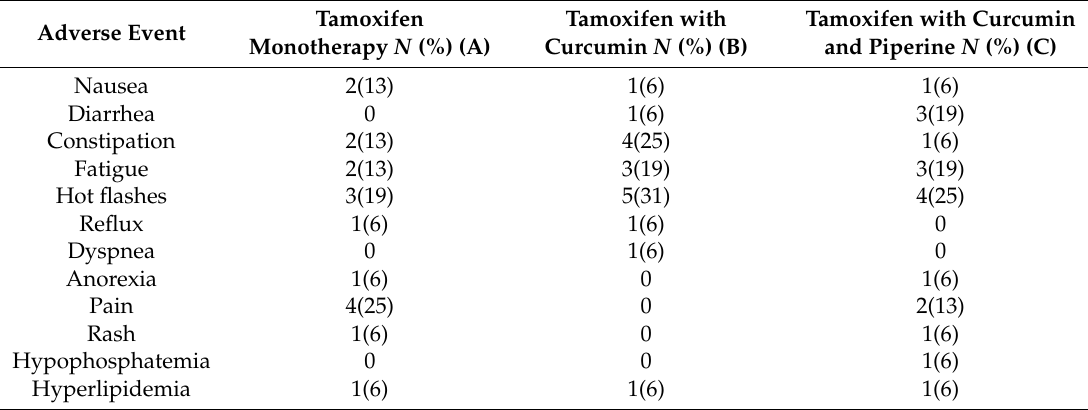
Table 4. Adverse